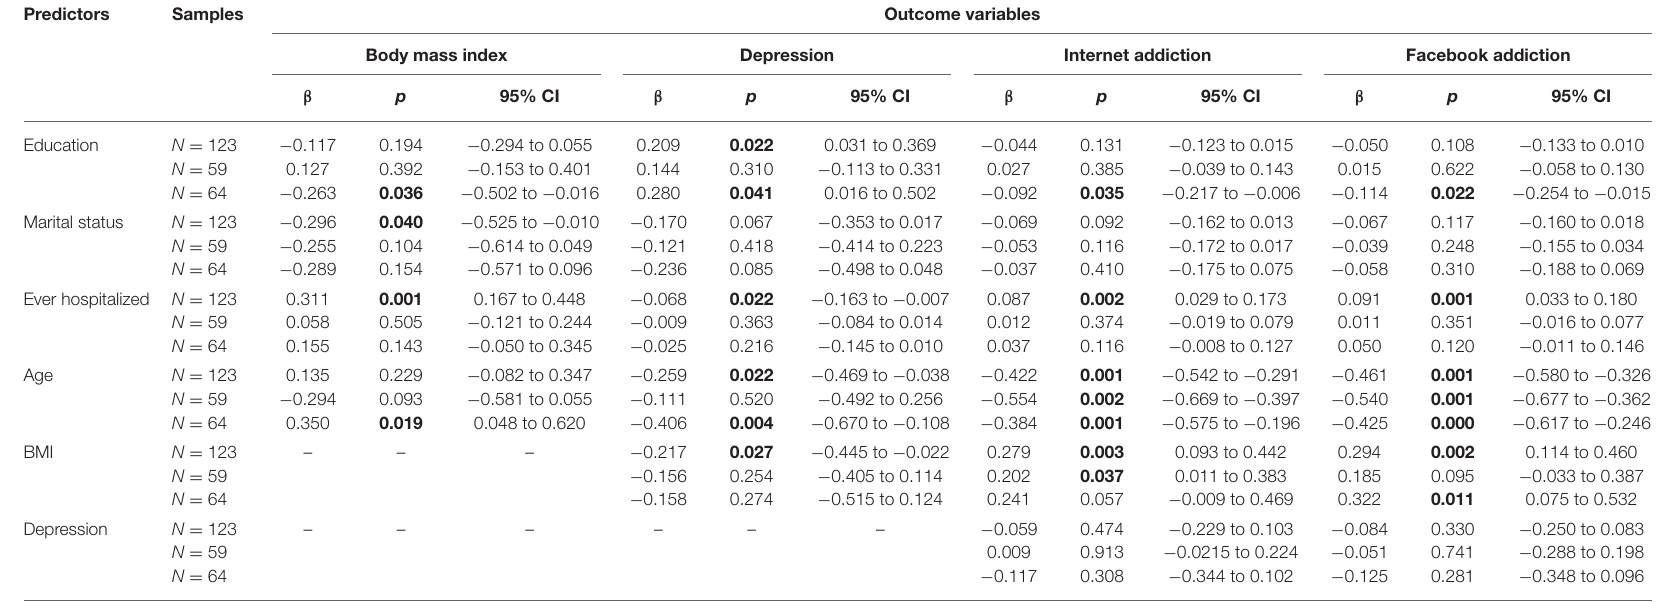
TABLE 4 | Standardized regression weights of the total effects of predictors of internet addiction and Facebook addiction along with p -values and 95% confidence interval.